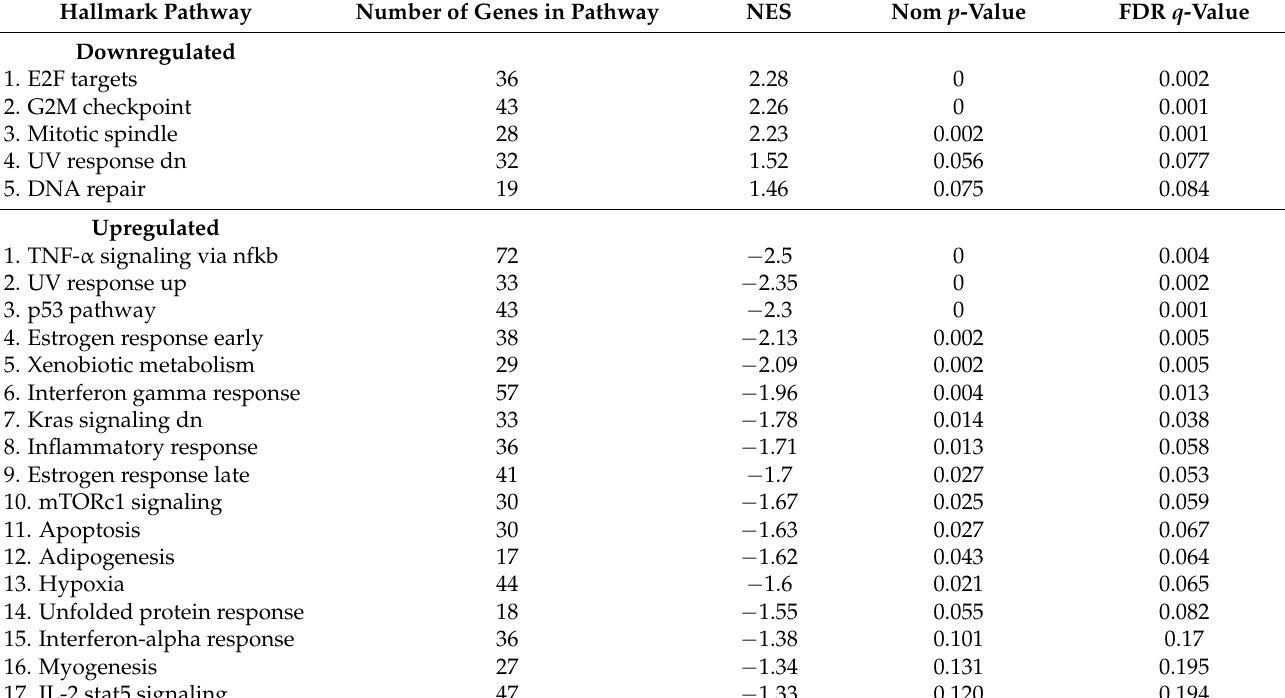
Table 3. Gene set enrichment analysis (GSEA) results according to the MSigDB hallmark gene sets.